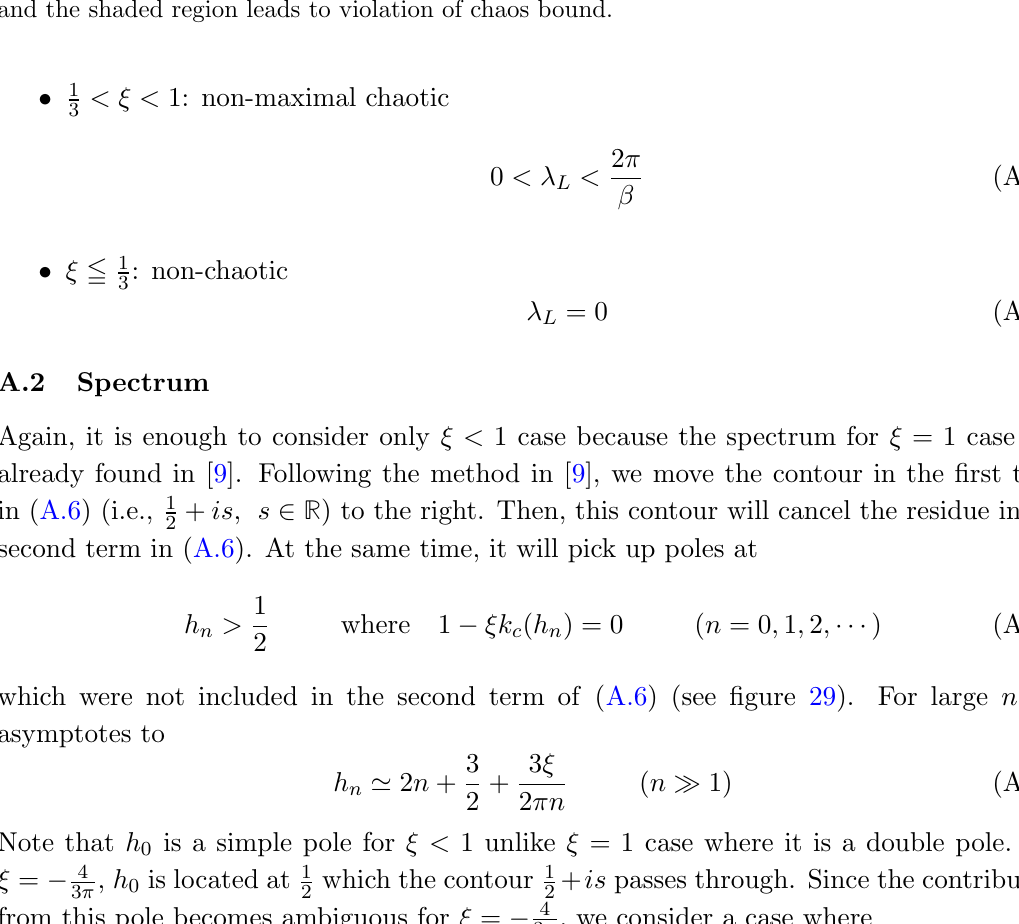
Figure 29. The intersections of red curve and blue line are simple poles corresponding to conformal dimension h n ( n = 0 ; 1 ; 2 ; (cid:1) (cid:1) (cid:1) ). The black line represents (cid:24) = 1 case which exhibits maximal chaos, and the shaded region leads to violation of chaos